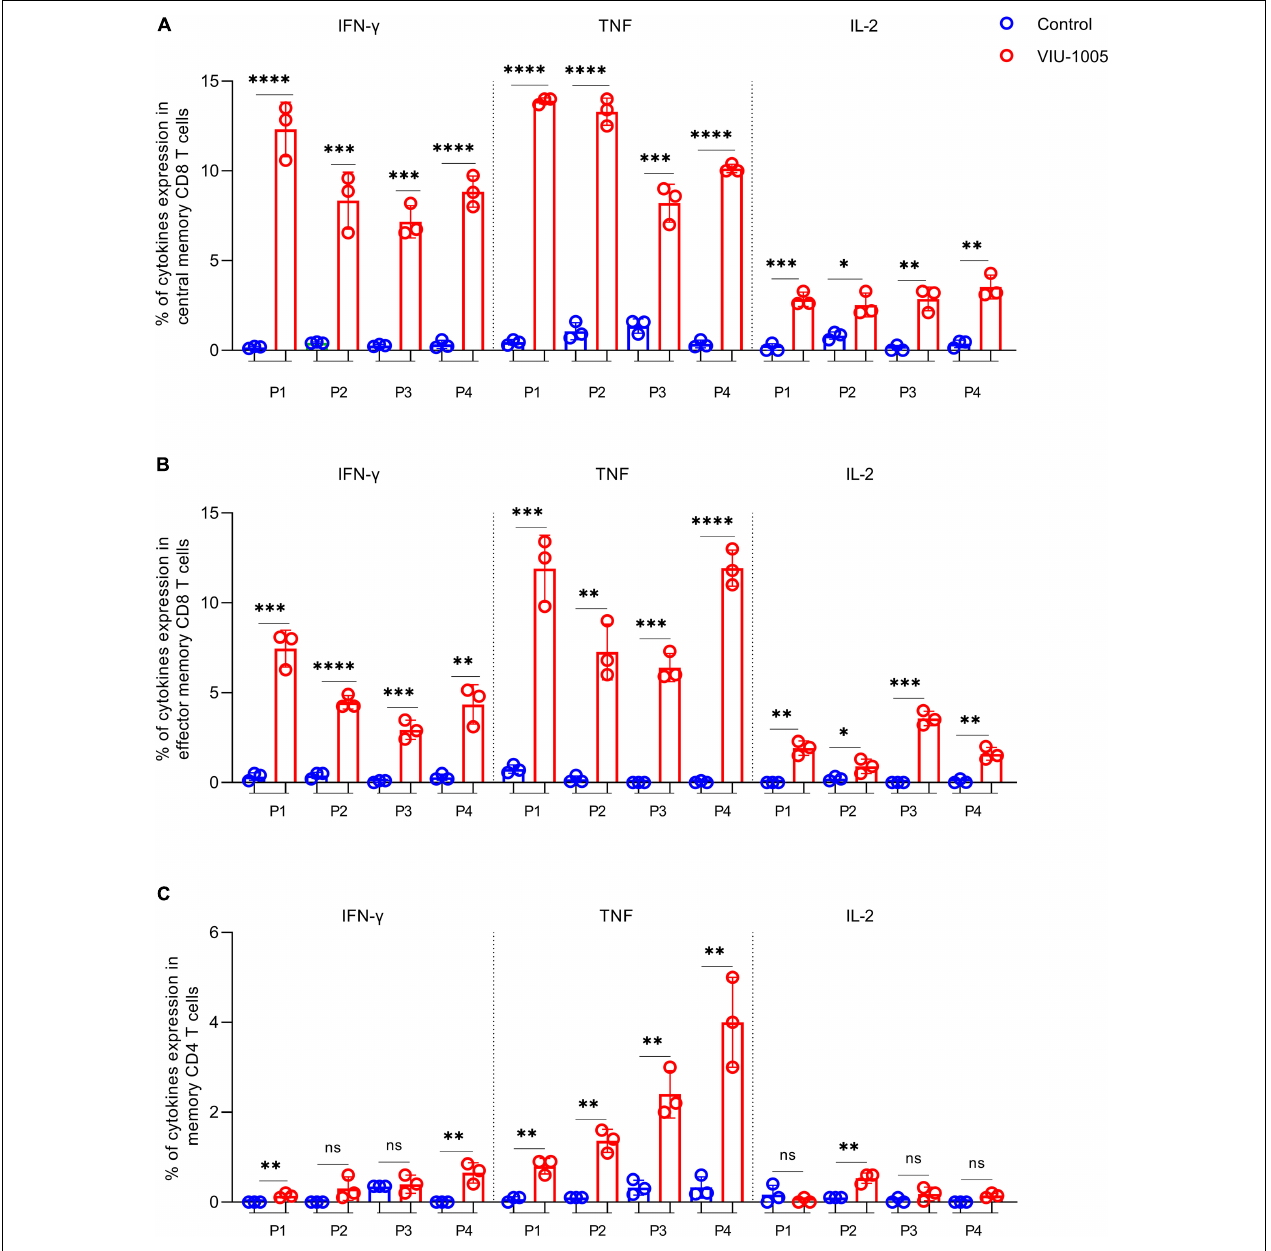
FIGURE 4 | Long-lasting cellular immune response against SARS-CoV-2 S protein in BALB/c mice. Intramuscularly immunized BALB/c mice with 100 µ g of VIU-1005 or control plasmid using needle injection were sacrificed at 25 weeks after the primary immunization, and splenocytes ( n = 3) were isolated and restimulated ex vivo with synthetic peptide pools covering SARS-CoV-2 S protein. Gating strategy on live CD8 + CD44 + CD62L + central memory T cells (CD8 + TCM), effector CD8 + CD44 + CD62L − memory T cells (CD8 + TEM), and memory CD4 + CD44 + CD62L − T cells, and representative plots are shown in Supplementary Figure 2 . Histograms display IFN- γ , TNF- α , and IL-2 expression on stimulated CD8 + TCM, CD8 + TEM, and memory CD4 + T populations from immunized BALB/c mice after restimulation with the different peptide pools. Data are shown as the mean ± SD for each group from one experiment ( n = 3).